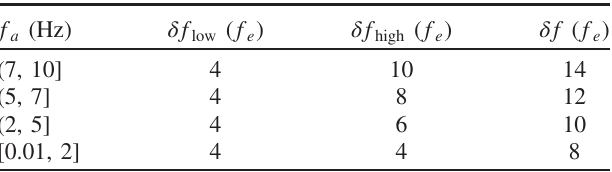
δ f TABLE I. Bandwidth δ f ¼ δ f spanning frequen- low þ high − δ f δ f ; f cies ½ f that is used to calculate the like- a a þ low high (cid:2) lihood for an axion with mass f . Note that the bandwidth is a asymmetrical about f since the axion power spectrum is itself a asymmetrical due to the fact that the axion ’ s kinetic energy can ≈ 11 . 6 μ Hz is the frequency of Earth ’ s only be positive. f e rotation with respect to distant